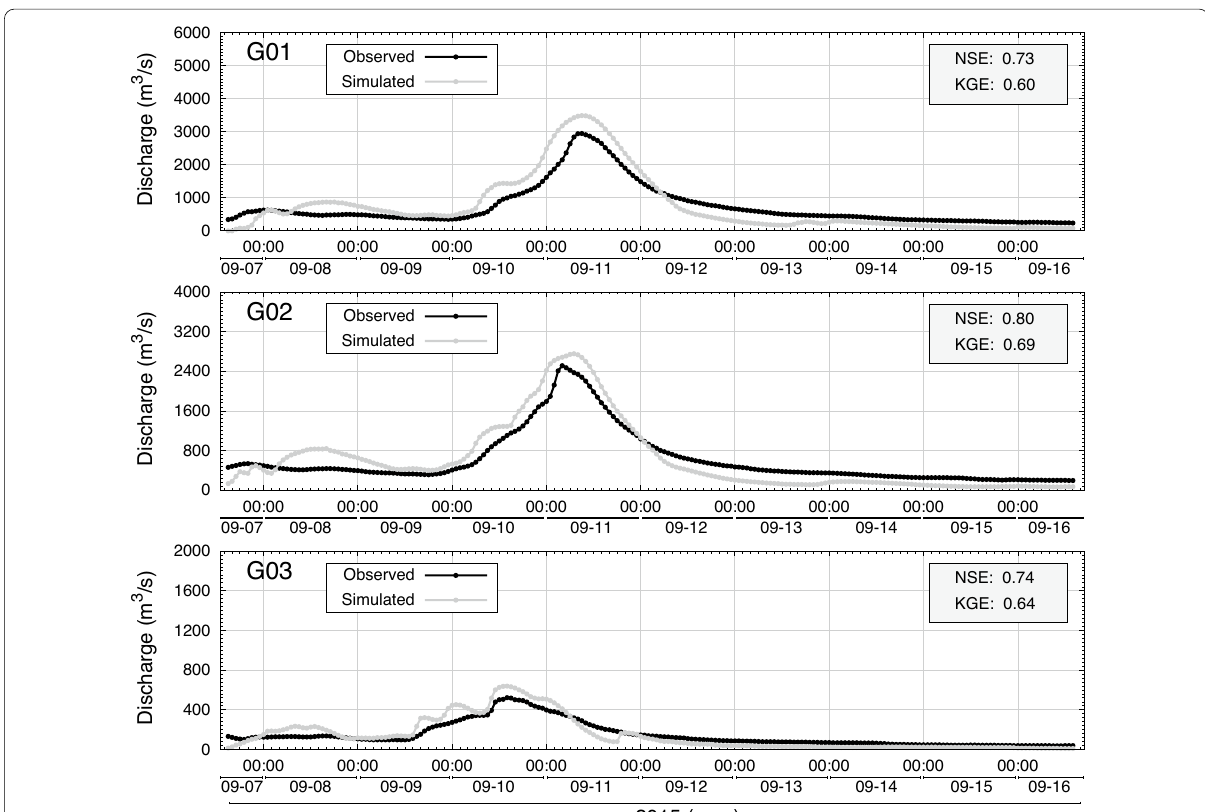
Fig. 3 Time-series profile of simulated discharge by RRI and observed discharge at three hydrological stations (G01, G02, and G03) for the event